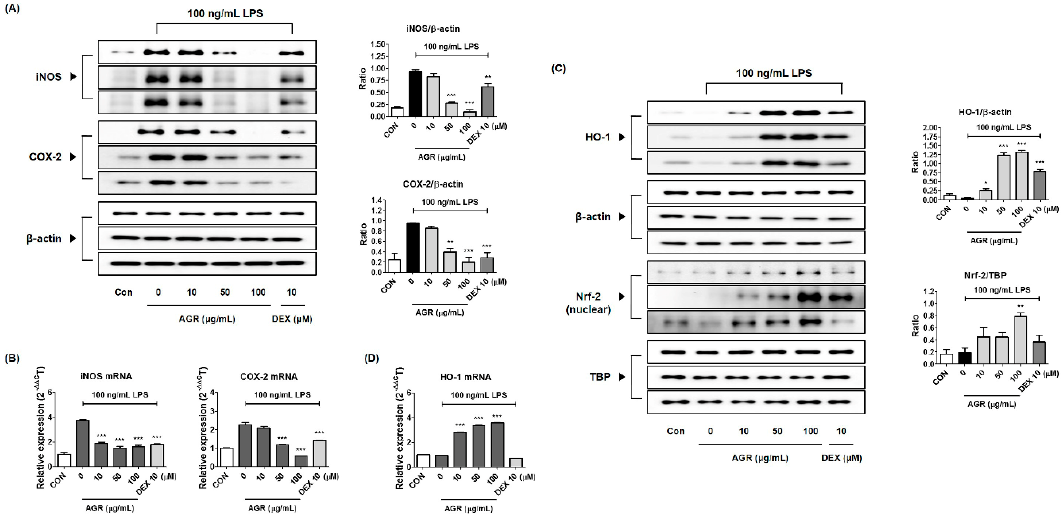
Figure 2. Effects of AGR on ( A ) protein production, ( B ) mRNA expression of iNOS, COX-2, and ( C , D ) production of HO-1, Nrf-2. Microglia cells were stimulated with LPS for ( A , B ) 12 h, ( C ) 6 h (HO-1) or 3 h (Nrf-2), or ( D ) 3 h. The histograms show protein and mRNA expression levels relative to those of β -actin or TBP. Data represent the mean ± SEM of three independent experiments. * p < 0.05, ** p < 0.001, and *** p < 0.0001 were calculated from comparisons with LPS stimulation values.